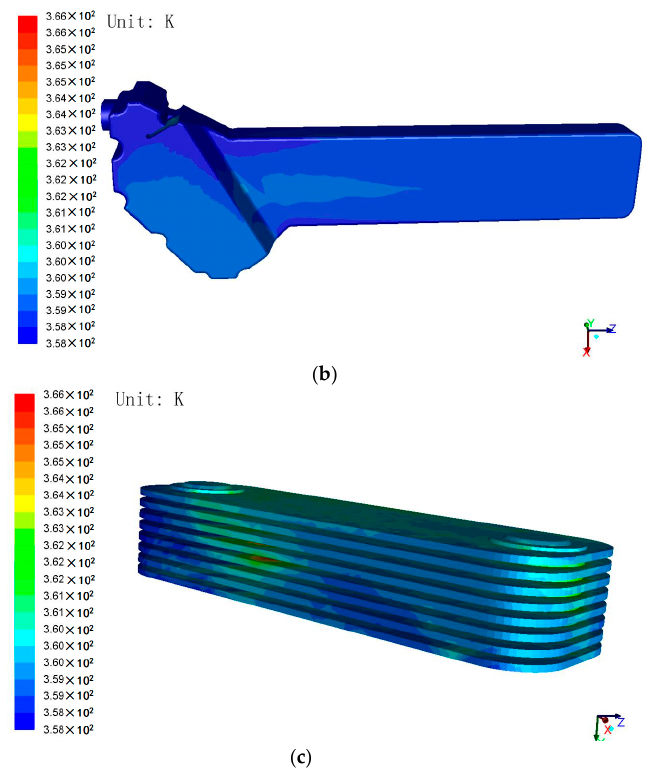
Figure 11. The CFD results of the oil cooling system, ( a ) the pressure distribution and ( b ) the temperature distribution of the water cavity, and ( c ) the temperature distribution of the oil cooler.